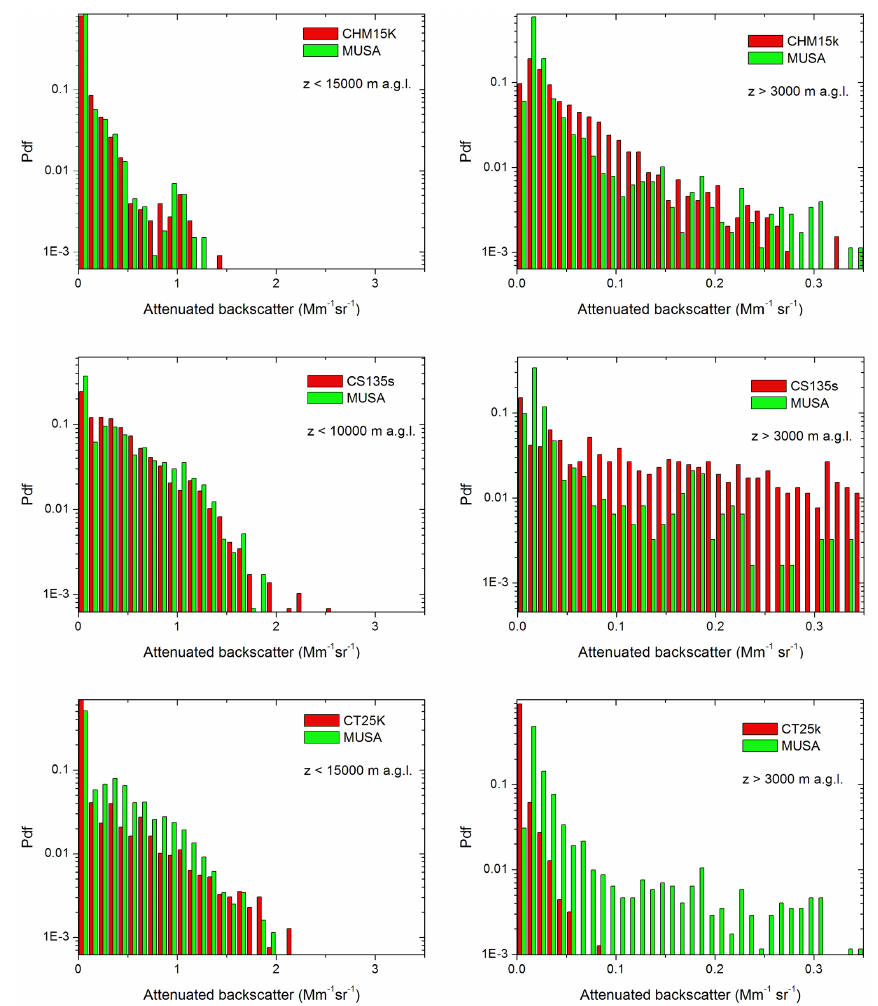
Figure 9. Probability density function of attenuated backscatter coefficient values retrieved from simultaneous observations performed by CHM15k and MUSA (upper panels), CS135s and MUSA (middle panels), CT25K and MUSA (lower panels). Left panels include all the values available from each instrument, right panels include only the values measured between above